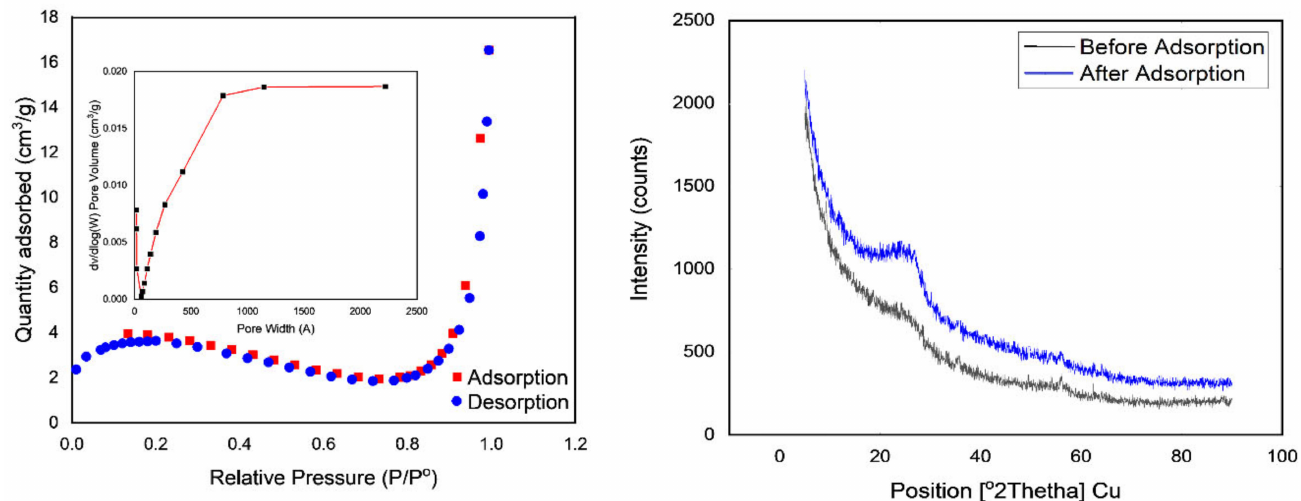
Figure 3. ( a ) N 2 gas adsorption/desorption isotherms of PPy-PEI ( b ) X-ray diffraction of PPy-PEI before and after the adsorption